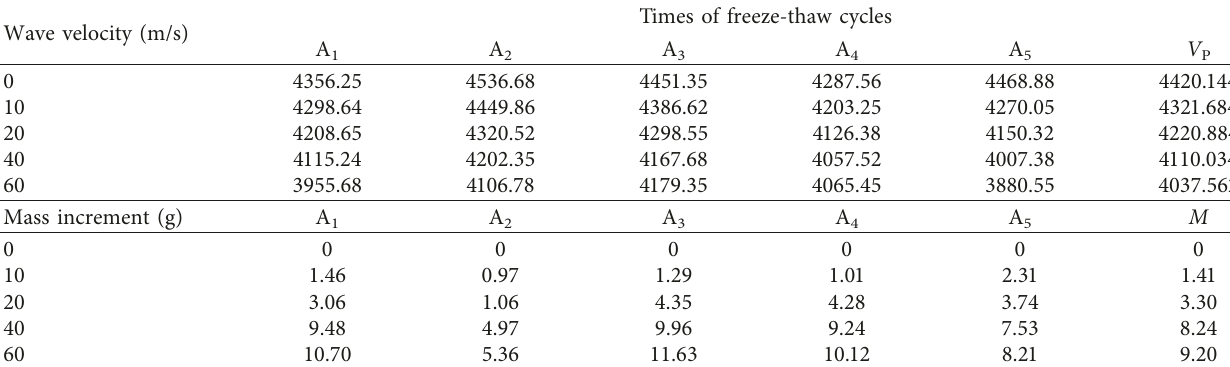
Figure 4: Mechanical testing instrument. (a) Triaxial apparatus (RMT-150). (b) Creep deformation apparatus (RLM-2000). Table 1: Physical parameters of tuffaceous sandstone samples under different freeze-thaw cycles.